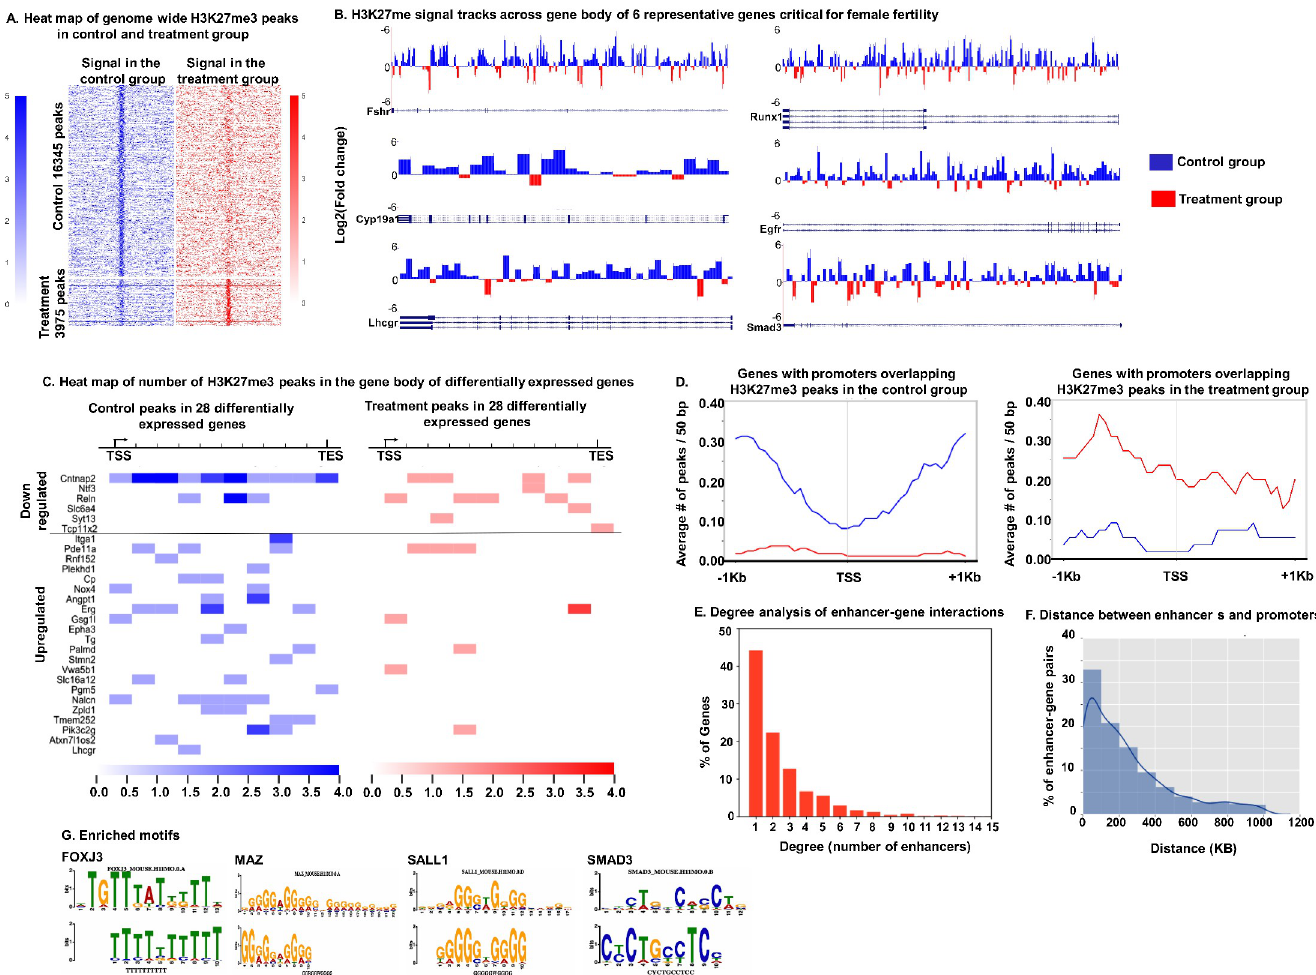
Fig 2. Genes associated with androgen-induced decrease in H3K27me3 mark in the gene body and overlapping with promoters and distal enhancers involving long-range regulation of gene expression. A: Heat maps showing the read density change along the peak regions for the 16345 control peaks and the 3975 treatment peaks. B: H3K27me3 signals in control and DHT treatment groups along the gene body of Fshr- follicle stimulating hormone receptor, Cyp19a1- aromatase, Lhcgr- luteinizing hormone/Choriogonadotropin receptor, Runx1 - runt-related transcription factor 1, Egfr –epidermal growth factor receptor and Smad3 - Mothers against decapentaplegic homolog 3. Log2 fold change was calculated as log2{(H3K27me3 control signal)/ (H3K27me3 treatment signal)}. Regions along the gene body with higher signals in the control group are represented as positive value- blue peaks and regions where signal was higher in the treatment group are shown as negative value-red peaks. C: Heatmap showing H3K27me3 peak counts in control and DHT-treated samples for 28 differentially expressed genes identified by comparing genes containing H3K27me3 peaks in the gene body with DEGs from the RNA-seq data. D: Average number of H3K27me3 peaks per 50bp overlapping with the promoter regions of 160 genes in the control samples and 55 genes in the DHT-treated samples. E: Degree analysis of enhancer-gene interactions for genes associated with significant decrease in H3K27me3 peaks in their enhancer regions with respect to DHT treatment. F: Distance between the promoters of genes and their corresponding enhancers that have decreased H3K27me3 signal by DHT treatment. G: Enriched transcription factor binding motifs in distal enhancers of genes associated with decrease in H3K27me3 signal with DHT treatment. E-values were < 0.1 and indicate the probabilities of observing the enrichment from random control DNA sequences. For each transcription factor, the upper motif logo corresponds to the consensus motif based on HOCOMOCO database and the lower motif logo corresponds to the observed sequence motifs that are enriched in linked distal enhancers.